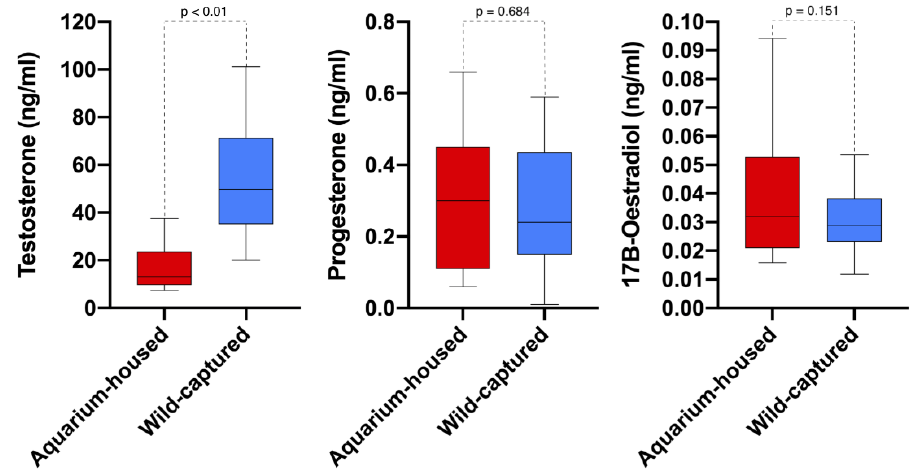
Figure 4. Box plot comparing blood hormonal sexual values between aquarium-housed and wild- captured small-spotted catshark ( Scyliorhinus canicula